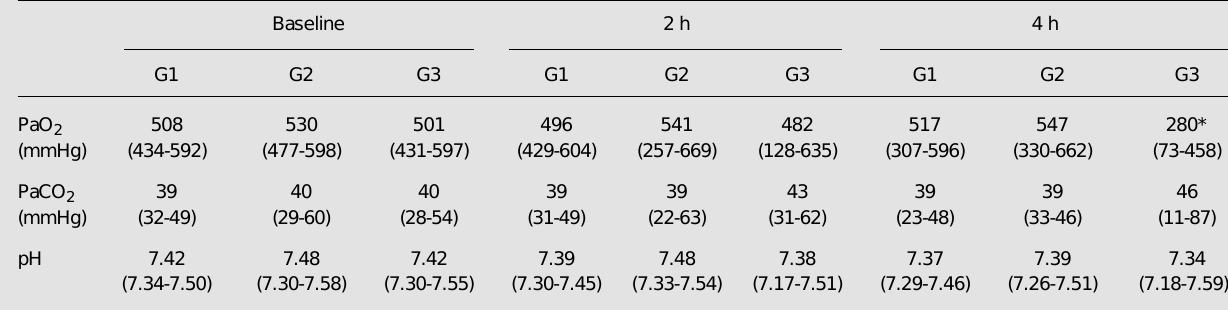
Table 1. PaO 2 , PaCO 2 and pH in the three groups at baseline and after 2 and 4 h of mechanical ventilation.